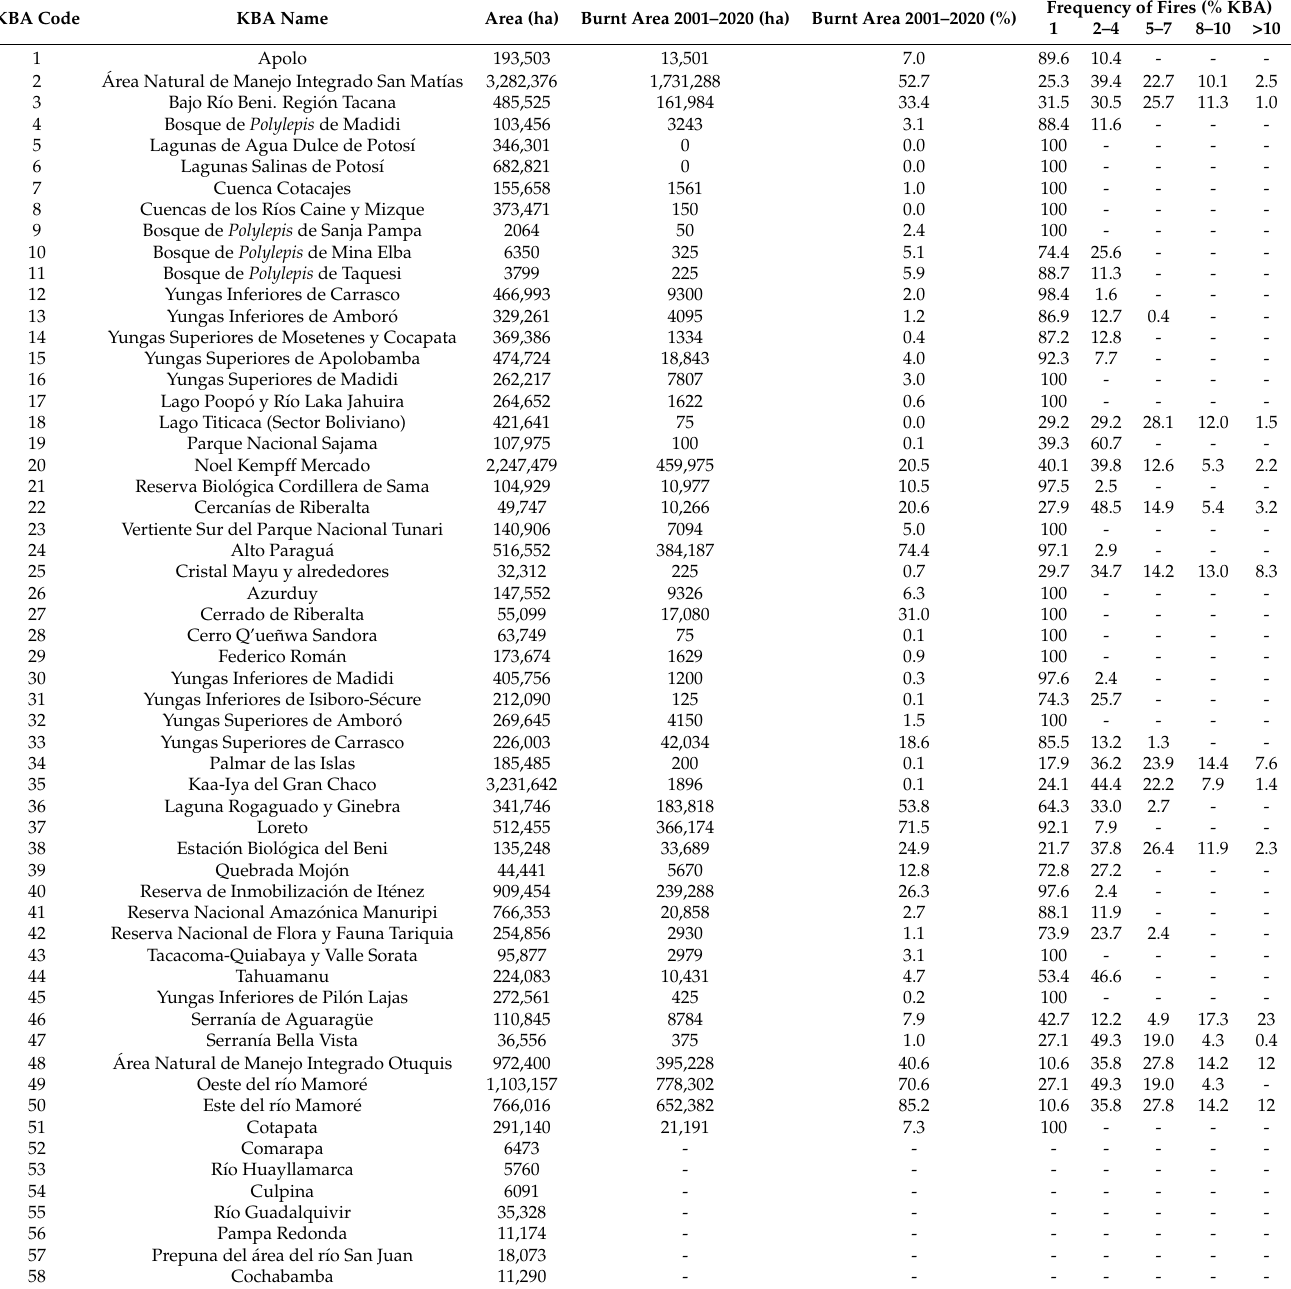
Table A1. Area and frequency of fires in the KBAs of Bolivia, in the period